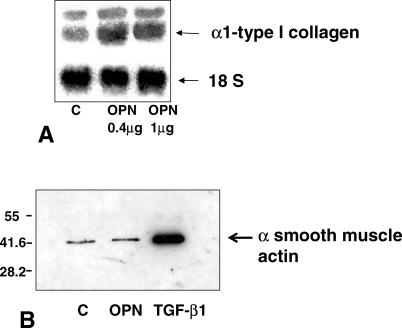
Effects of Osteopontin on Collagen Gene Expression and Smooth Muscle Alpha Actin Protein in Human Lung Fibroblasts(A) Northern blot of 20 μg total cellular RNA per lane extracted from control and fibroblasts stimulated with 0.4 μg/ml and 1 μg/ml osteopontin. Both concentrations of osteopontin induced an up-regulation in the expression of α1 type I collagen.(B) Western blot showing no effect of osteopontin on immunoreactive α smooth muscle actin. Recombinant TGF-β1 was used as a positive control.C, control; OPN, osteopontin.